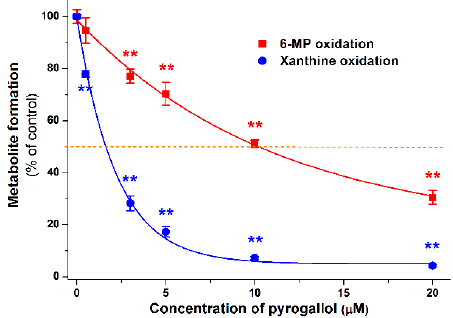
Figure 9. Inhibitory effect of PYR on 6-MP and xanthine oxidation. The 50% inhibition of metabolite formation (IC 50 ) is marked with dashed line (* p < 0.05; ** p < 0.01).